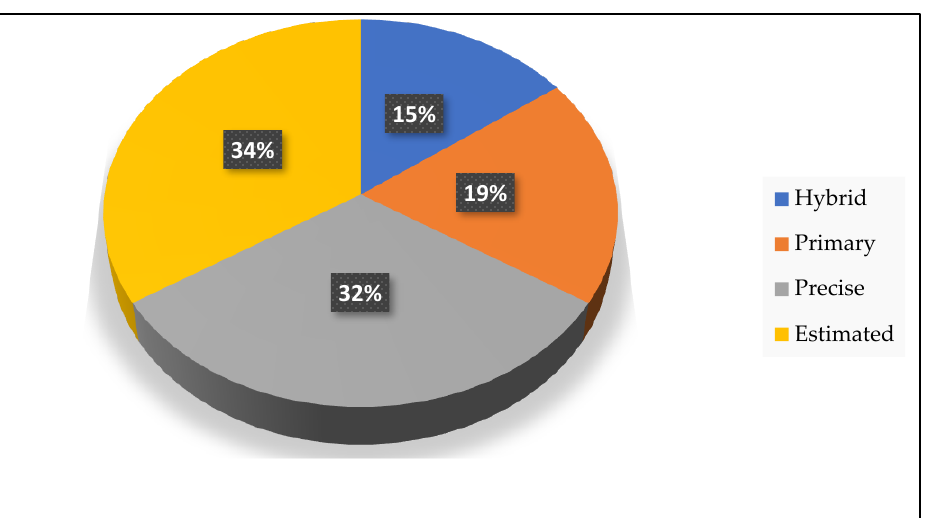
Figure 2. Year-wise research paper publications by publisher .